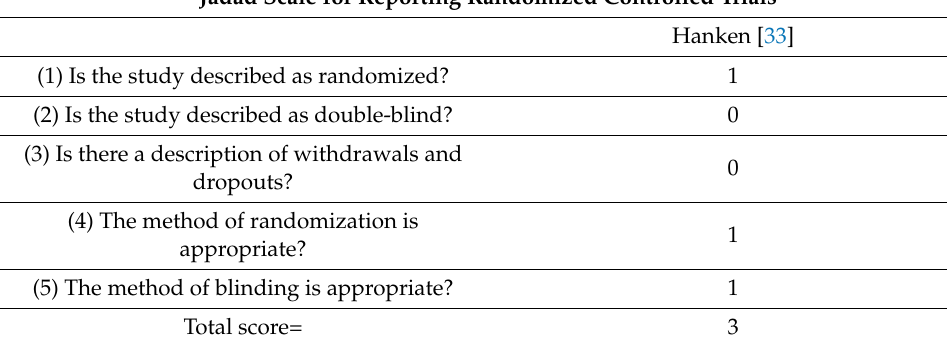
Table 2. Jadad Scale for randomized control trials. Jadad Scale for Reporting Randomized Controlled